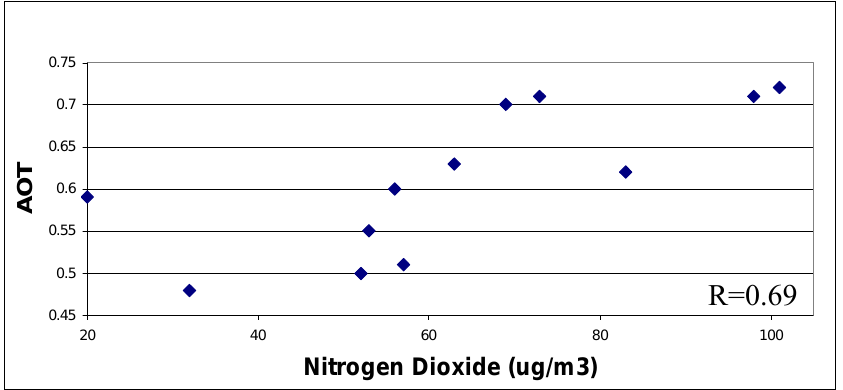
from the four air quality stations within one 2